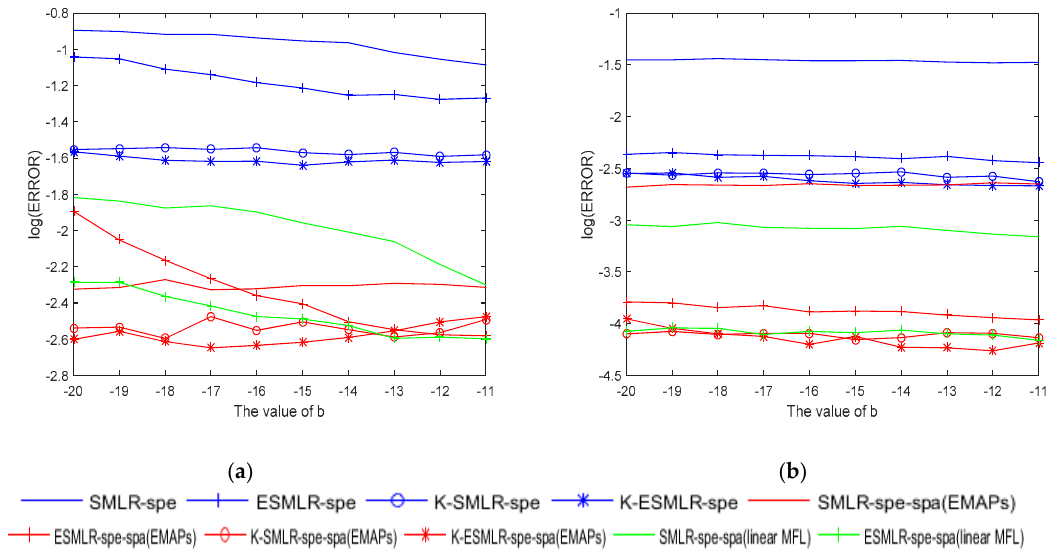
Figure 5. The impact of the sparse parameter b ( λ = 2 b ) in the proposed framework: ( a ) results on the Indian Pines dataset; ( b ) results on the Pavia University dataset.